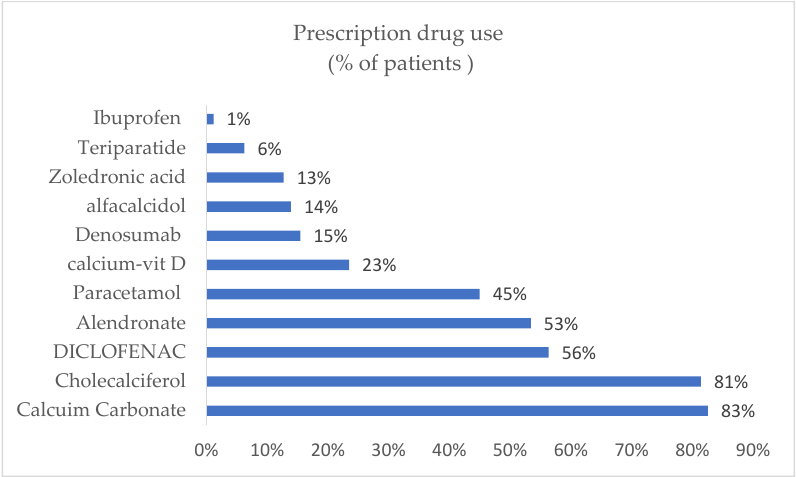
Figure 1. Medication utilization rates among patients with osteoporosis during the study period. Table 4. Costs of medications for the treatment of osteoporosis during the study period.